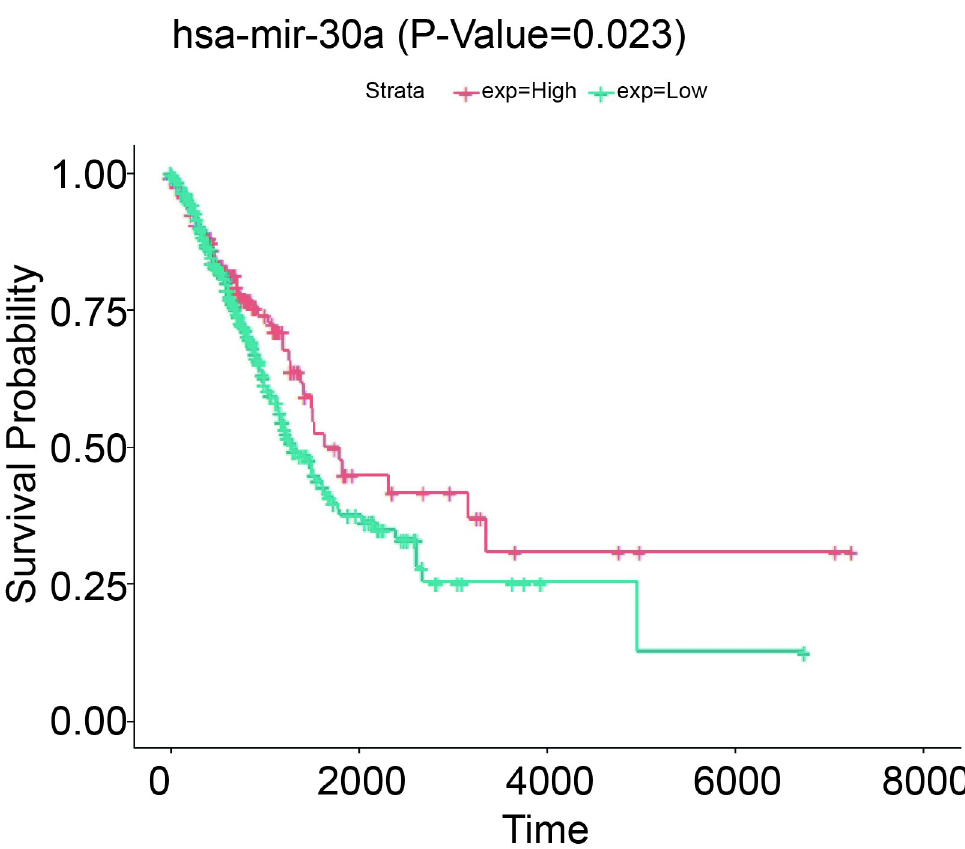
Fig 5. Survival analysis of differentially expressed hsa-mir-30a. The abscissa and ordinate represent respectively survival time (days) and survival rate. The blue and red lines represent respectively the low-risk and high-risk curves, p <